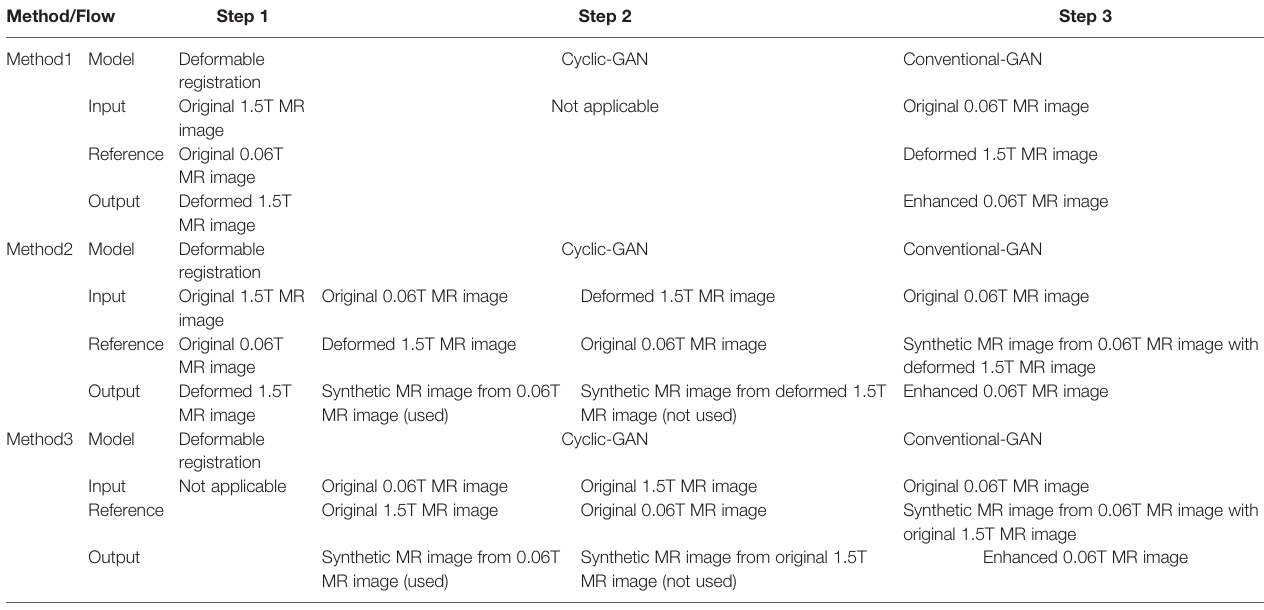
TABLE 1 | Work fl ow with deformed MR image and without synthetic MR image for method 1, 2 and 3.